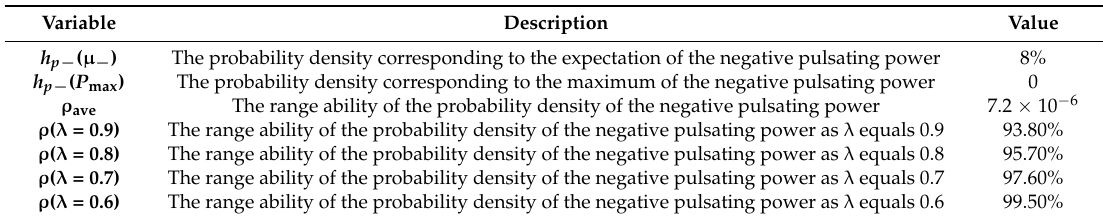
Table 2. Probability distribution of ρ ( λ ).